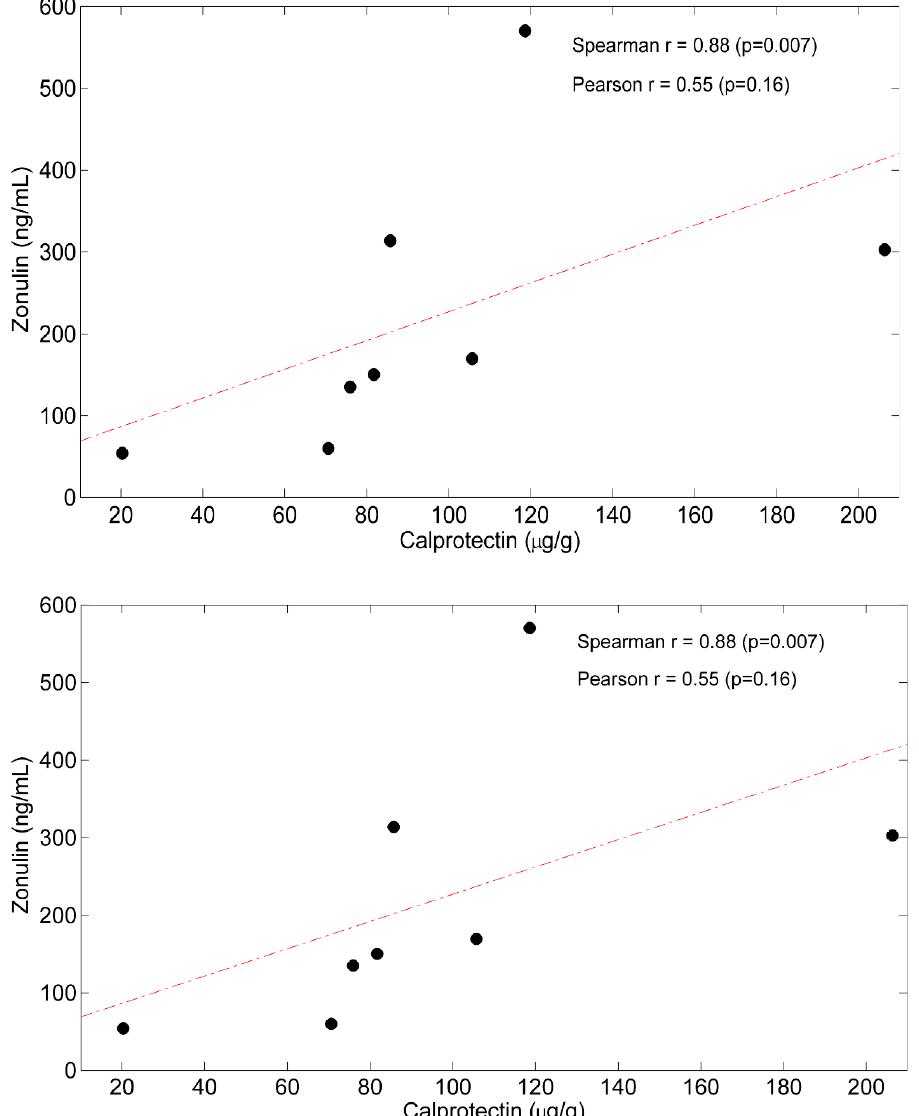
Figure 1. Scatterplot showing the association between baseline fecal Calprotectin and Zonulin. Spearman’s r and Pearson’s r are also reported. The red dash-dotted line represents the linear fit. With respect to the plasma AA profile (Table 4), compared to CTRLs, CKD patients had higher levels of aspartic acid ( p = 0.0005), asparagine ( p = 0.034), serine ( p = 0.016), histidine ( p = 0.002) and glycine ( p = 0.043) and higher phenylalanine/tyrosine ratio (phe/tyr ratio; p =